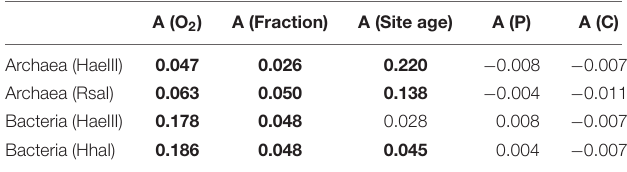
without the LF) as revealed by multi-response permutation procedure